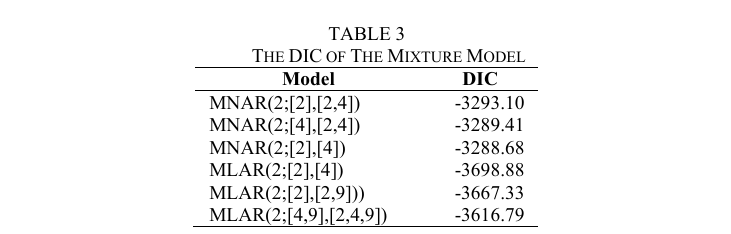
T HE SIGNIFICANCE OF T HE P ARAMETER IN T HE MNAR AND MLAR M ODEL Model